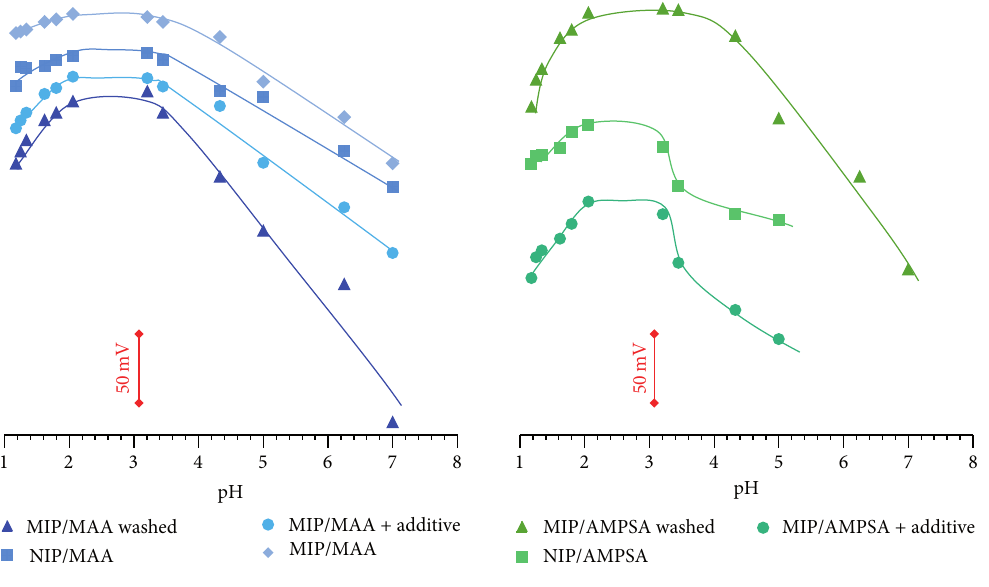
F 4: Reilley diagram for